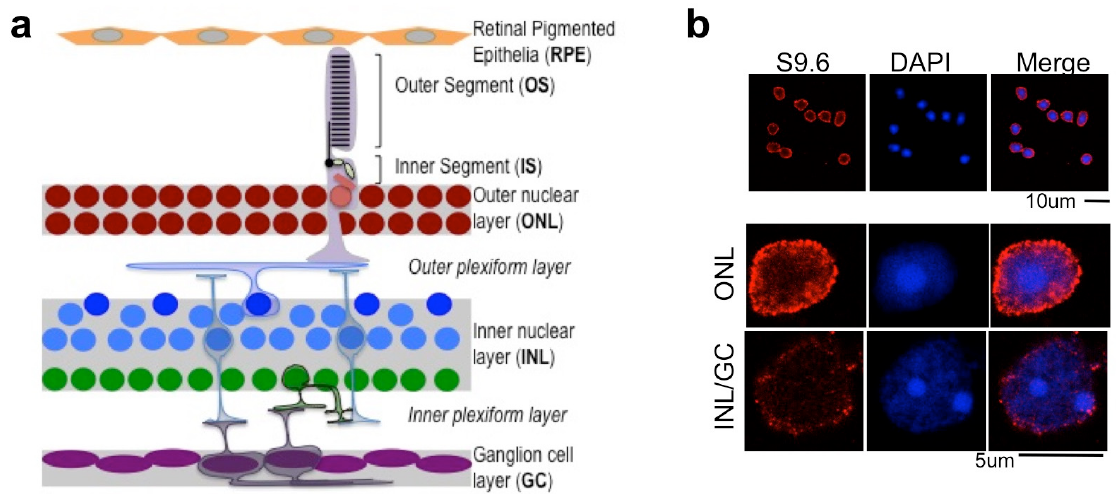
Figure 1. RNA:DNA-hybrids accumulate in photoreceptor nuclei. ( a ) Labelled diagram shows stratified organization of retinal layers and cell types. ( b ) Immunofluorescence with DNA:RNA hybrid specific S9.6 antibody of mice retinal cells. Tissue was proteolysed and disintegrated for staining (see Methods). Photoreceptors (outer nuclear layer cells) can be identified by typical inverted chromatin, as seen by DAPI